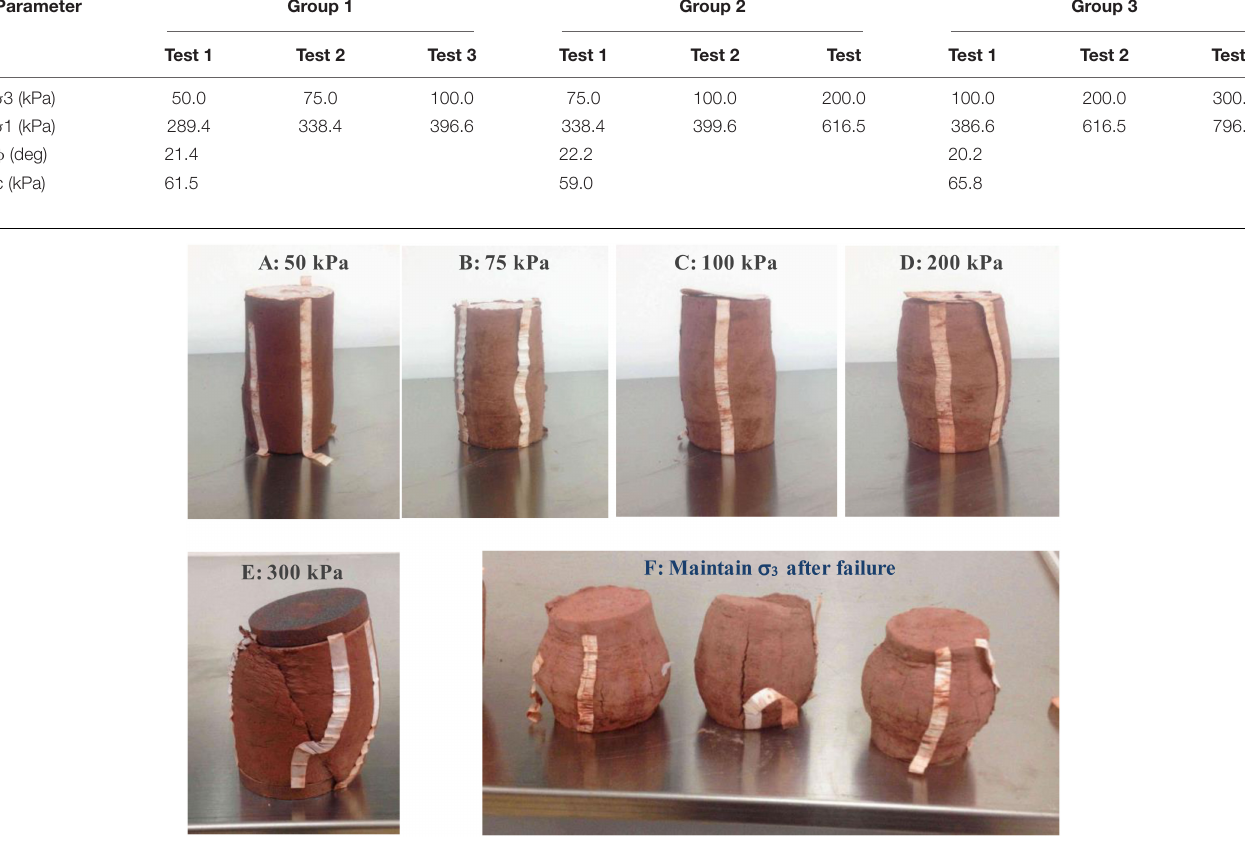
FIGURE 7 | Failure patterns after shear strength tests. (A–F) Represents different confining pressures.